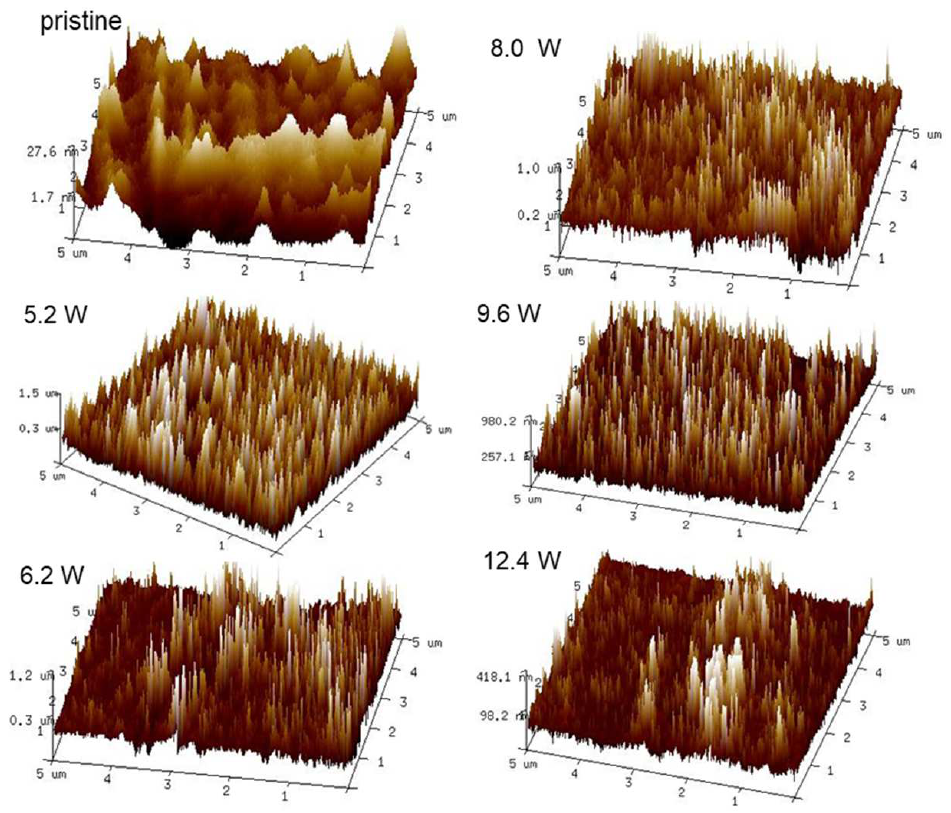
Figure 6. 3D-AFM images of polyimide before and after He–H 2 O plasma treatment at various discharge power conditions and at a fixed gas flow rate and treatment time of 30